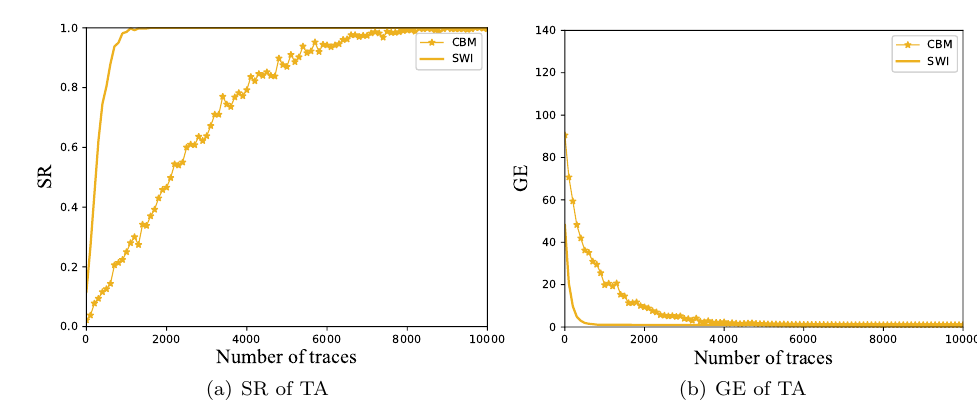
Figure 9: SR and GE results targeting L Gadget for redundant